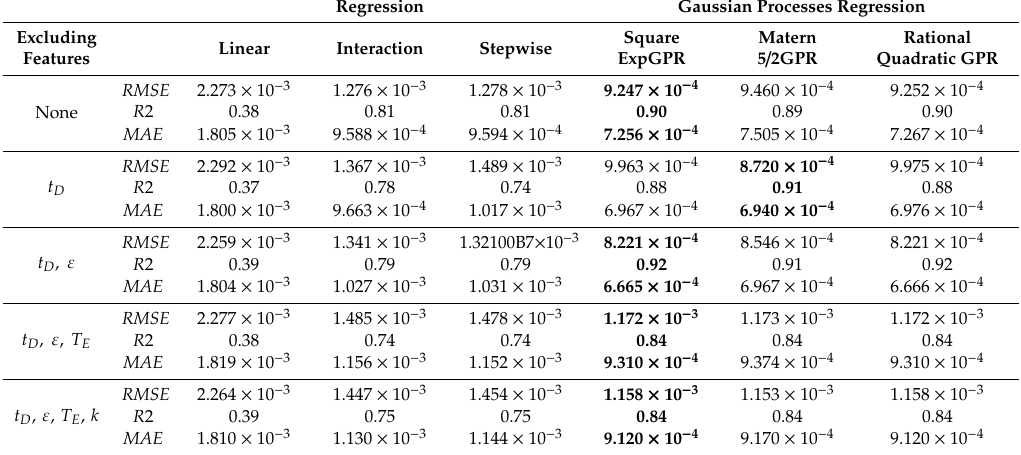
Figure 8. ( a ) Interaction regression model for all the features ( R 2 = 0.81, MAE = 9.588 × 10 − 4 ). ( b ) Gaussian Regression model for 8 features ( R 2 = 0.92, MAE = 6.666 × 10 − 4 ), including “Contrast Rear” and excluding defect thickness and emissivity coe ffi cient. Table 5. Performance results for defect length predictor models using a dataset of 500 sets of values. Part 1: Regression and Gaussian process regression model (GPR) when “Contrast Rear” is contemplated as feature. The models with the best predictive performance are indicated in bold